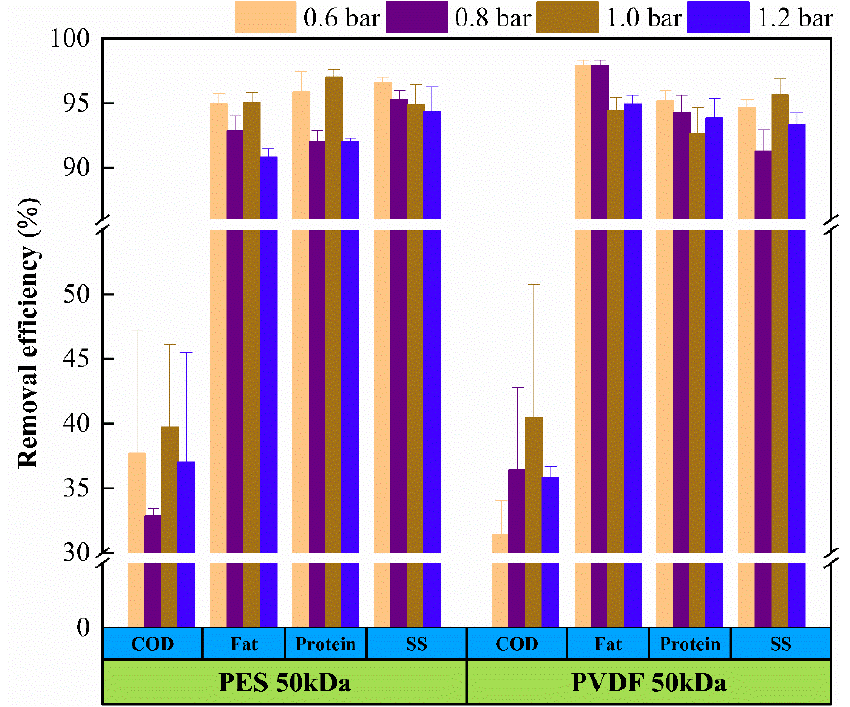
Figure 3. Pollutant removal efficiency of tanning wastewater ultrafiltration at different TMP (shear rate = 2.9 × 10 3 s − 1